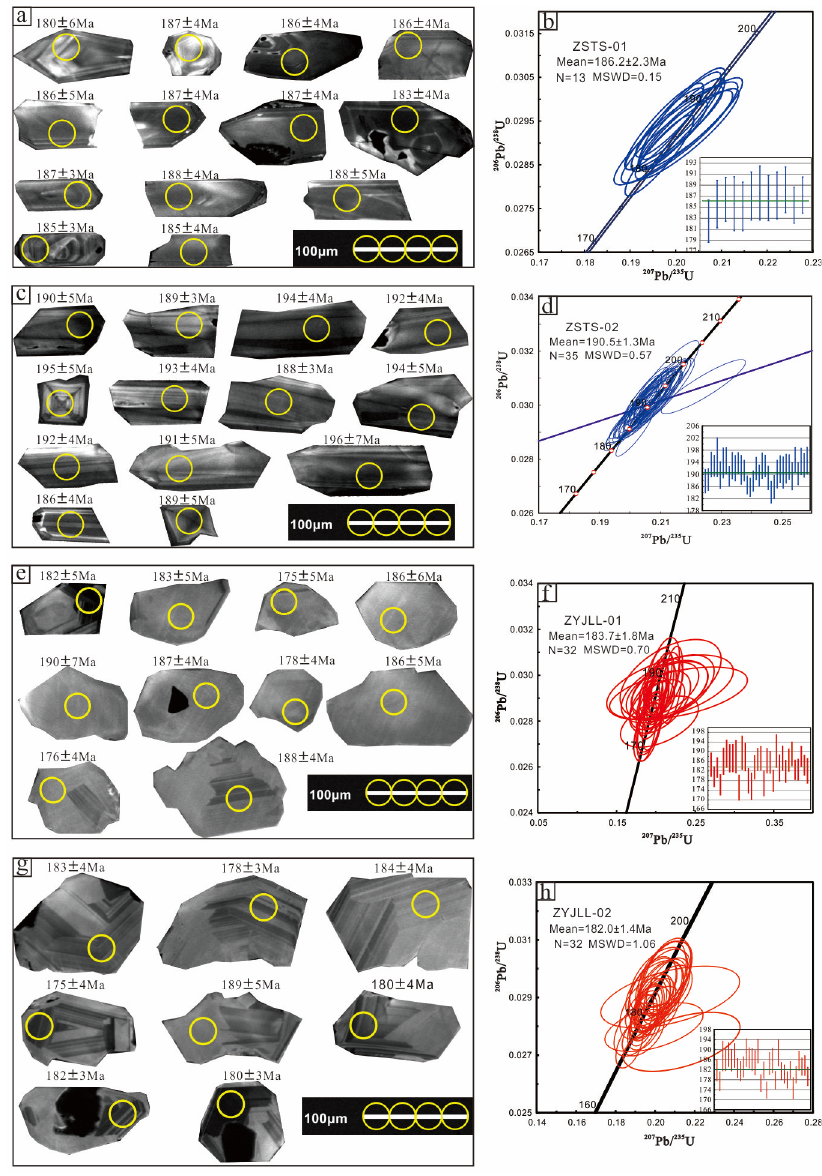
Figure 5. CL images of representative zircon grains ( a , c , e , g ), zircon U–Pb Concordia diagrams ( b , d , f , h ).